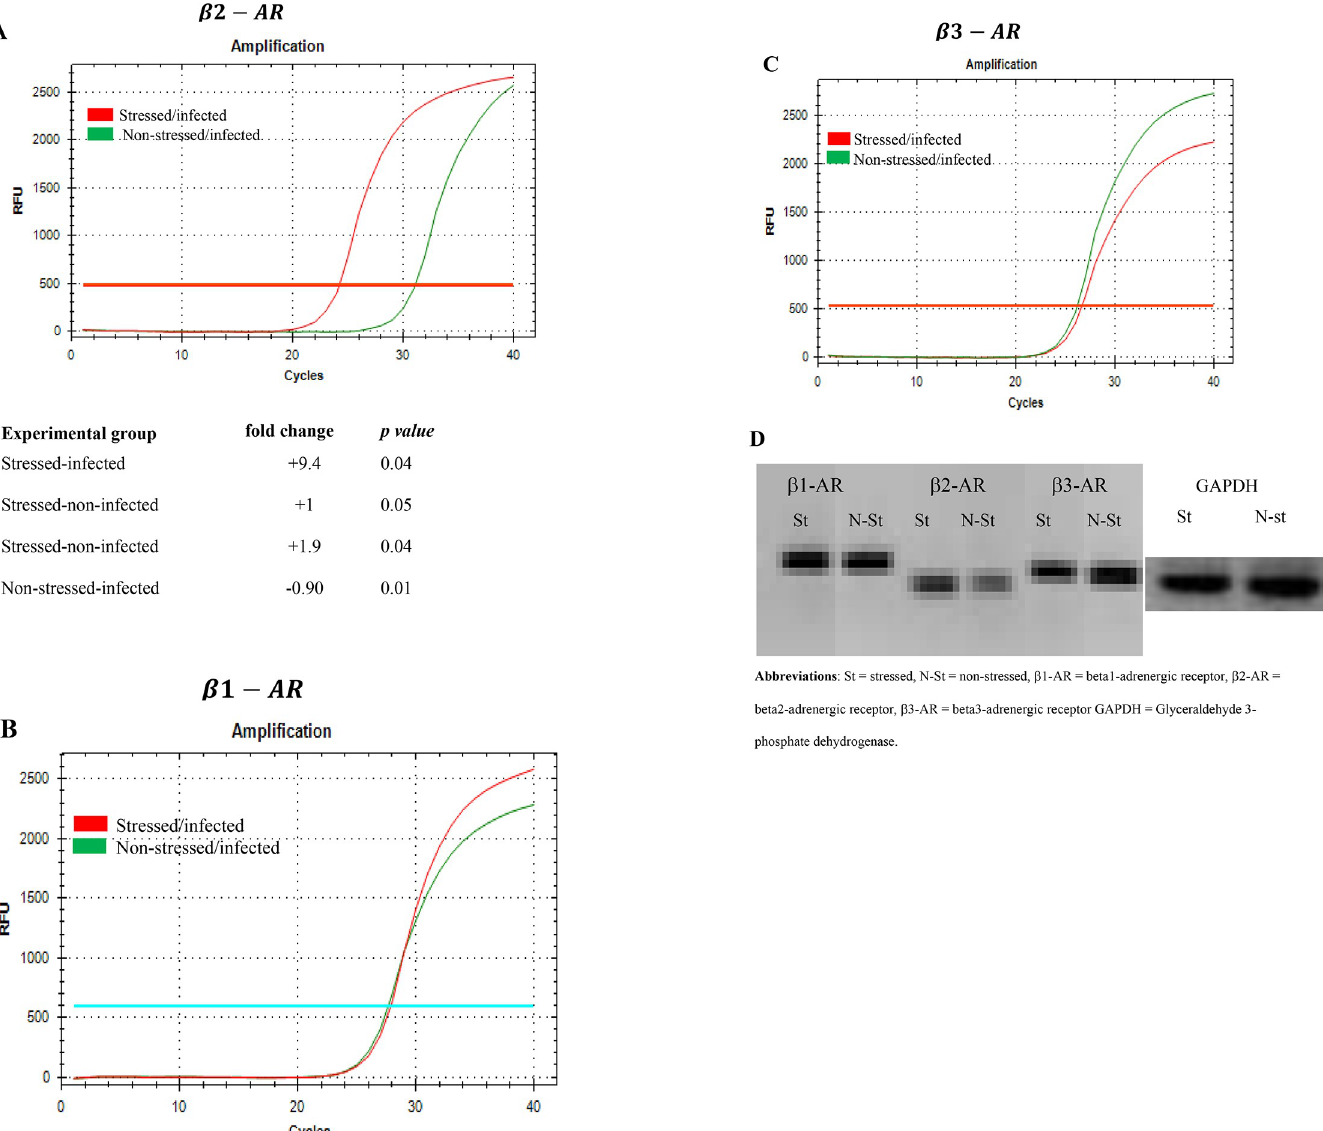
Fig 2. Gene expression profiles of β -AR) subtypes in CD4+ T cells isolated from the genital tract of stressed and non-stressed mice during C . muridarum genital infection. Amplification cures and fold-changes of mRNA levels of β 2-AR subsets normalized to the housekeeping gene, GADPH, is shown. A ) β 2-AR, B ) β 1 –AR, C ) β 3-AR, D) qPCR products on gel electrophoresis. Abbs : St = stressed, Non-St = none-stressed. Data shown are representative of two or more independent experiments run on different